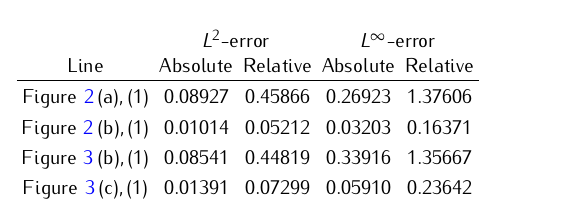
Table 1. Absolute and relative errors of the reconstructed